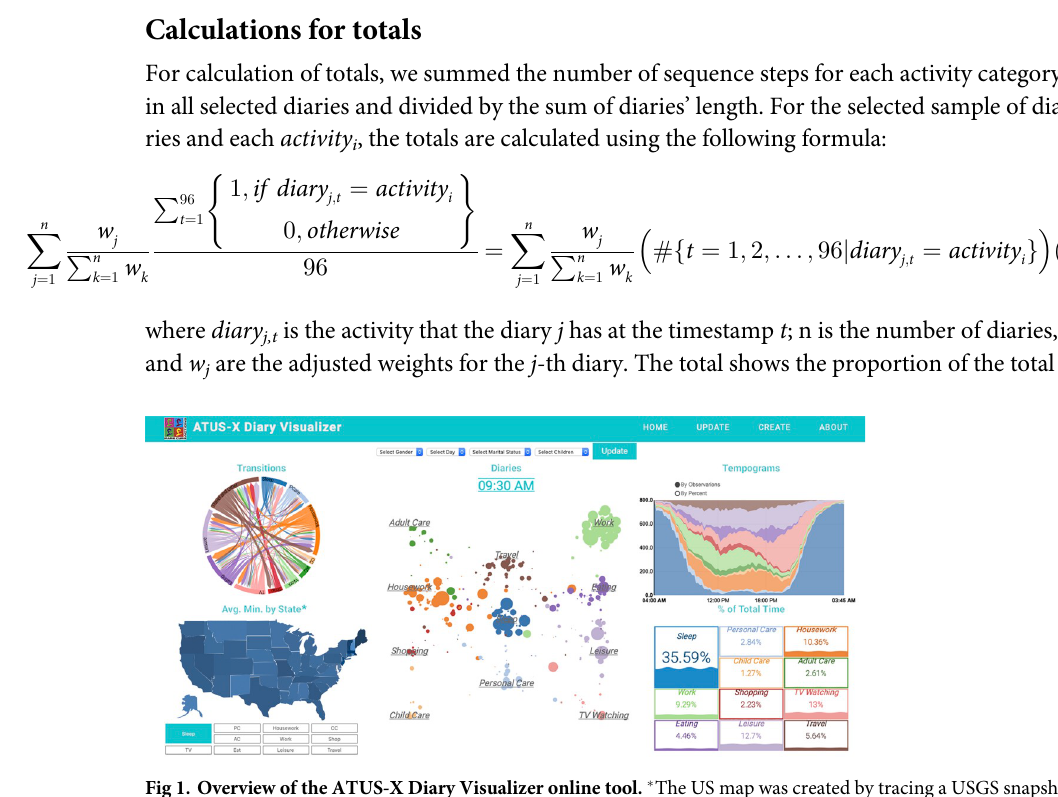
Fig 1. Overview of the ATUS-X Diary Visualizer online tool. � The US map was created by tracing a USGS snapshot and is not identical to the original image and is, therefore, for illustrative purposes only. Source: IPUMS ATUS Extractor: Sample of self-identified family caregivers from